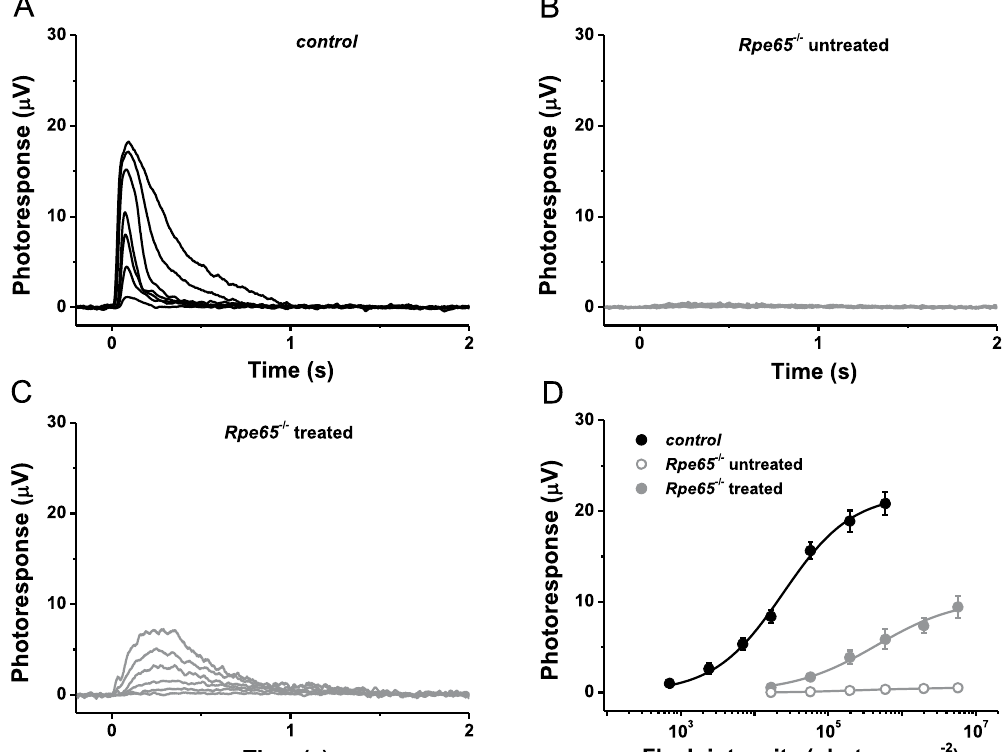
Figure 2. Treatment with 9- cis -retinal partially restores sensitivity of chromophore-deficient mouse cones. ( A ) Representative family of transretinal cone ERG responses from control Rpe65 + / + Gnat1 − / − mouse retinas. Test flashes of 505 nm light with intensities of 705, 2.4 × 10 3 , 7.0 × 10 3 , 1.7 × 10 4 , 5.7 × 10 4 , 2.0 × 10 5 , and 6.0 × 10 5 photons μ m − 2 were delivered at time 0. ( B ) Representative family of transretinal cone ERG responses from Rpe65 − / − Gnat1 − / − mouse retinas. Test flashes of 505 nm light with intensities of 1.7 × 10 4 , 5.7 × 10 4 , 2.0 × 10 5 , 6.0 × 10 5 , 2.0 × 10 6 , and 5.7 × 10 6 photons μ m − 2 were delivered at time 0. ( C ) Representative family of transretinal cone ERG responses from retinas of Rpe65 − / − Gnat1 − / − animals repeatedly injected with Matrigel loaded with 9- cis -retinal. Intensities of test flashes of 505 nm light were the same as in ( B ). ( D ) Averaged cone intensity-response functions (mean ± SEM) for control Rpe65 + / + Gnat1 − / − (n = 9), Rpe65 − / − Gnat1 − / − (n = 3), and 9- cis -retinal treated Rpe65 − / − Gnat1 − / − (n = 10) mice. Error bars for some points are smaller than the symbol size. Hyperbolic Naka-Rushton fits yielded half-saturating intensities ( I 1/2 ) of 2.4 × 10 4 and 4.5 × 10 5 photons μ m − 2 for control and Rpe65 − / − Gnat1 − / − animals treated with 9- cis -retinal, respectively. Because of their small values, data for untreated Rpe65 − / − Gnat1 − / − mice were not fitted with Naka-Rushton functions and connected with straight lines